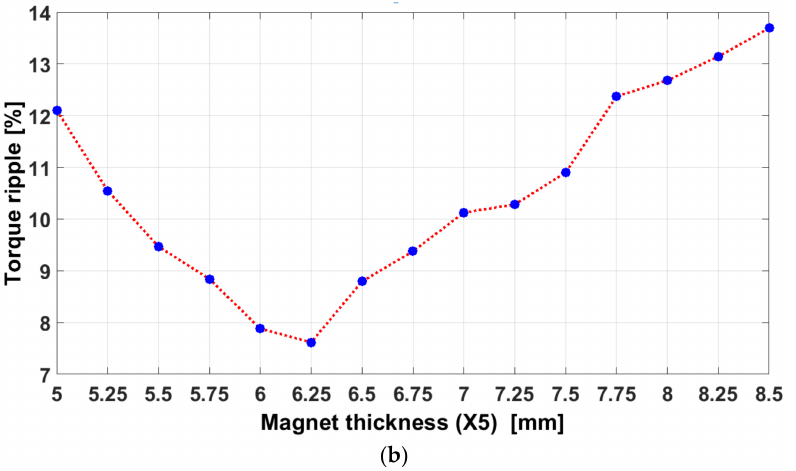
Figure 8. Impact of the central magnet thickness variation on: ( a ) the average torque; ( b ) the torque ripple.